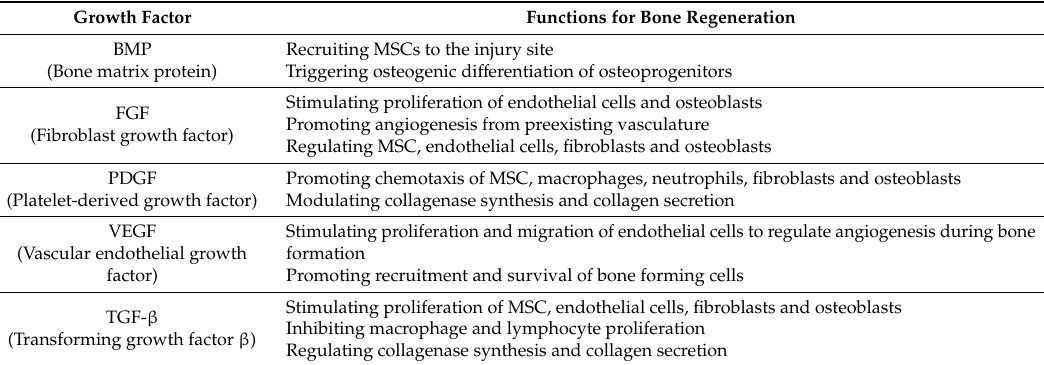
Table 1. Main functions of growth factors used in bone tissue engineering